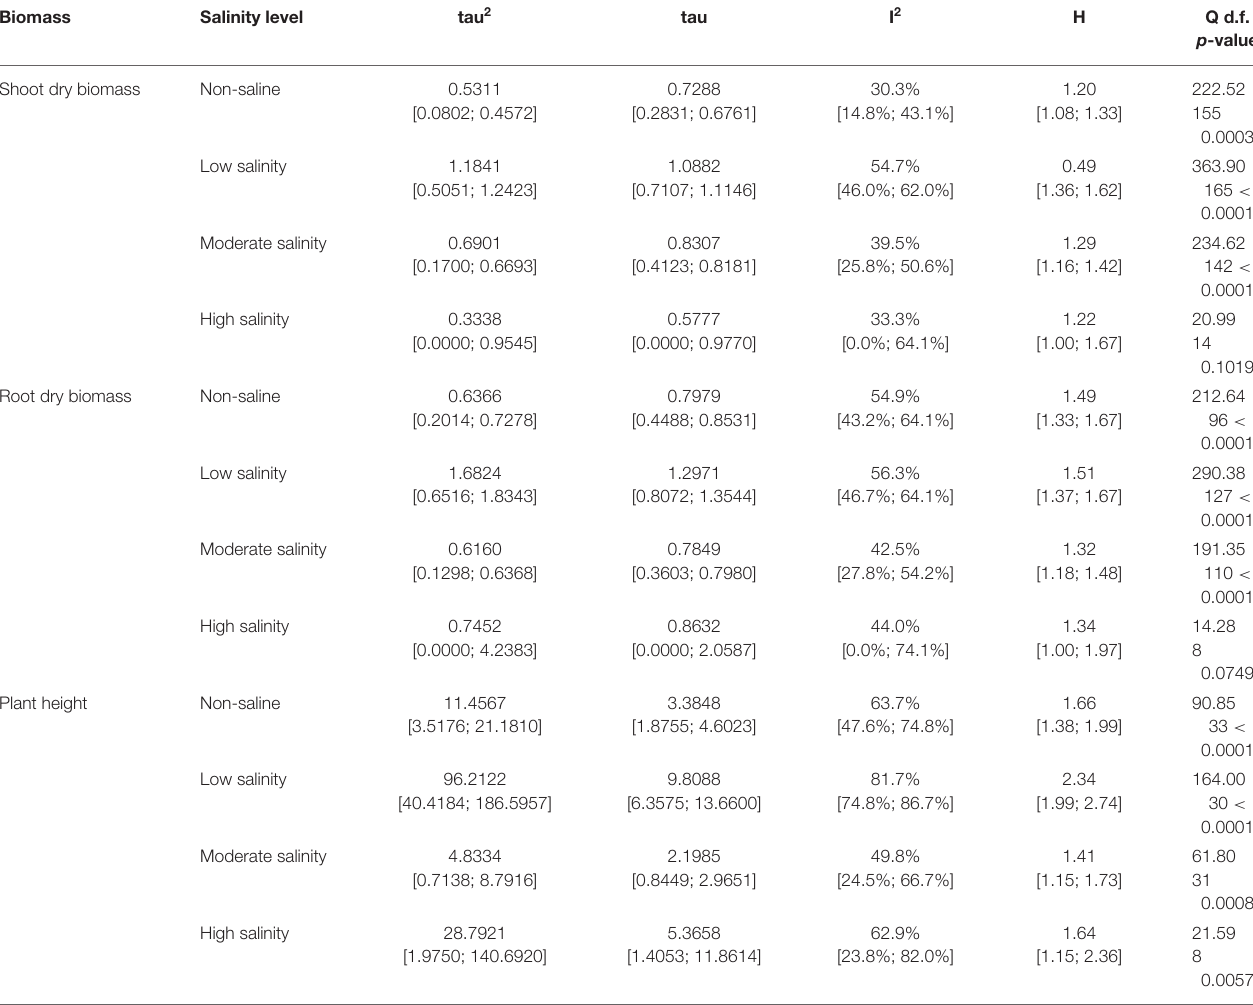
TABLE 1 | Heterogeneity statistics for the three biomass summary effect sizes under non-stressed and salinity stress conditions.